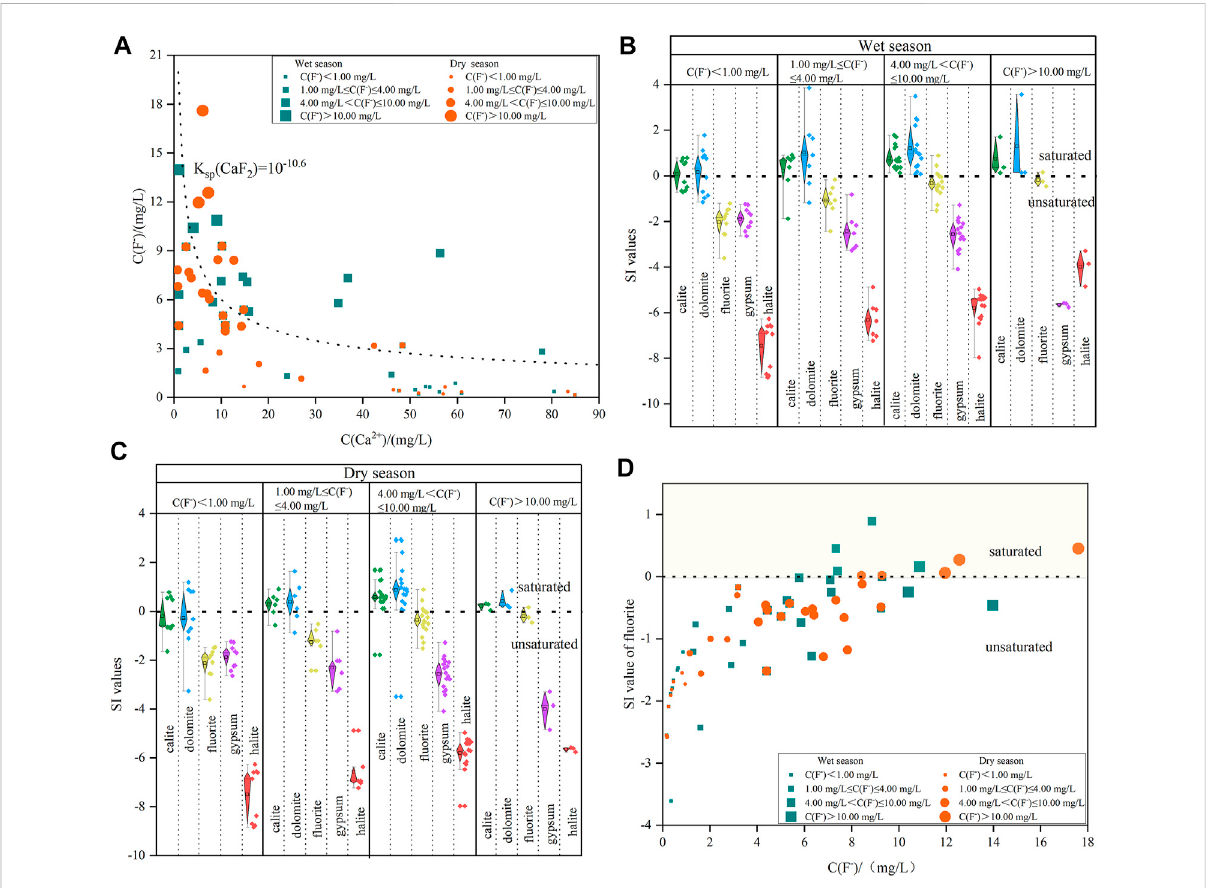
FIGURE 5 The plots of: (A) Ca 2+ versus the F - content; (B) the boxplots of SI values of minerals during the wet season; (C) the boxplots of SI value of minerals during the dry season; (D) the SI fl uorite versus the F - content in deep